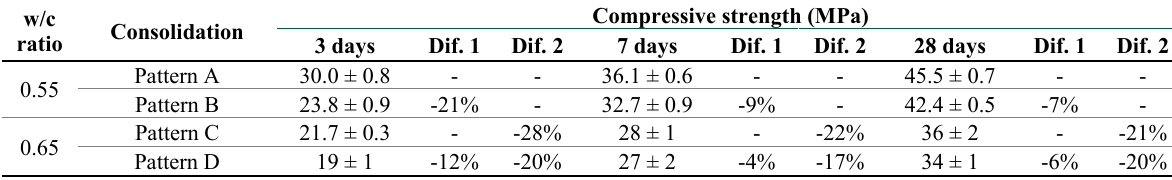
Table 5. Average compressive